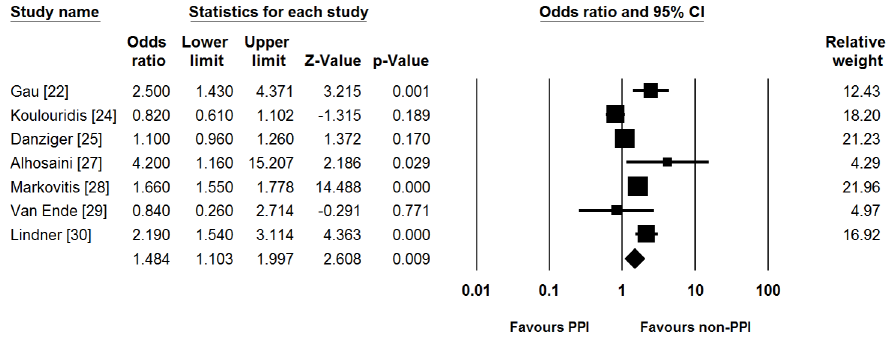
Figure 2. Forest plots for risk of hypomagnesemia. PPI, proton pump inhibitor; CI, confidence interval.